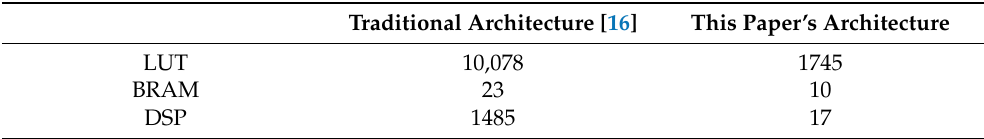
Table 2. Comparison of resource consumption between traditional architecture and this paper’s